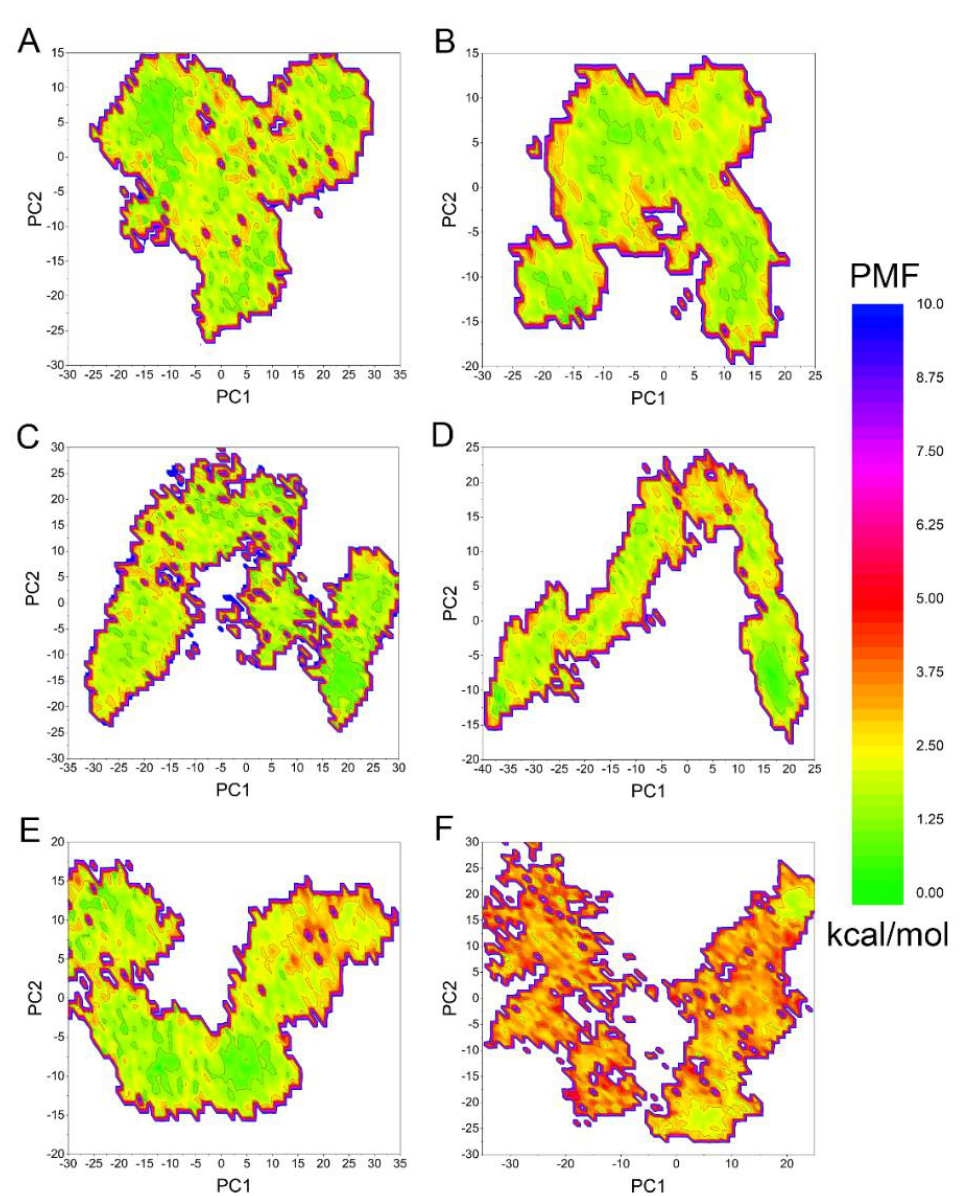
Figure 7. Free energy map calculated from the projection of the structures extracted from aMD simulations on the main components PC1 and PC2. ( A ) Mps1 WT /reversine; ( B ) Mps1 C604Y /reversine; ( C ) Mps1 WT /Cpd-5; ( D ) Mps1 C604Y /Cpd-5; ( E ) Mps1 WT /NMS-P715; ( F ) Mps1 C604Y /NMS-P715.